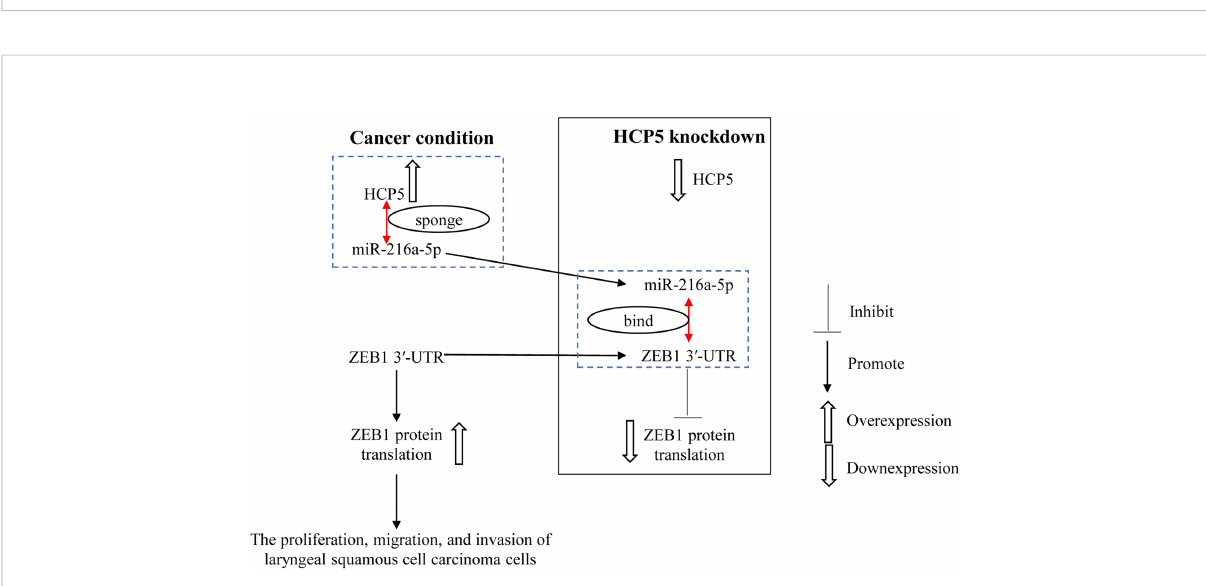
FIGURE 7 miR-216a-5p binds with ZEB1 3 ′ -UTR to inhibit ZEB1 expression. HCP5 enhances the malignant biological function of LSCC cells by sponging miR-216a-5p to promote ZEB1 expression.